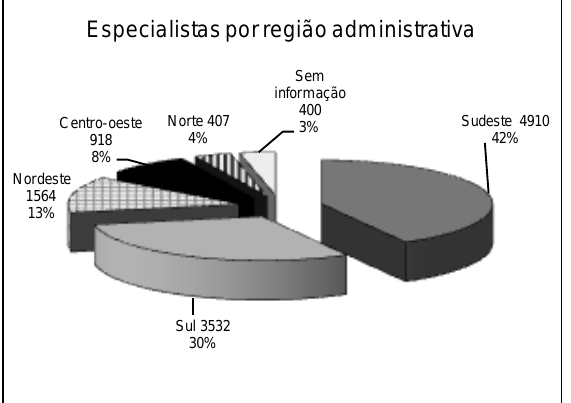
Figura 8. Especialistas por região administrativa. Fonte: Portal da